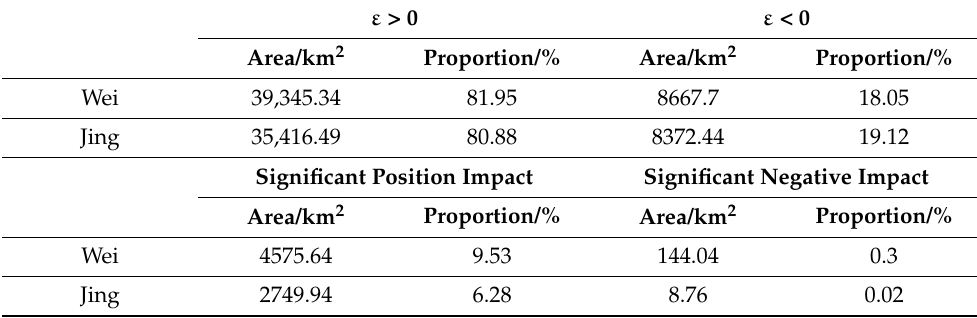
Table 2. The residual area and proportion of Wei and Jing basins from 1987 to